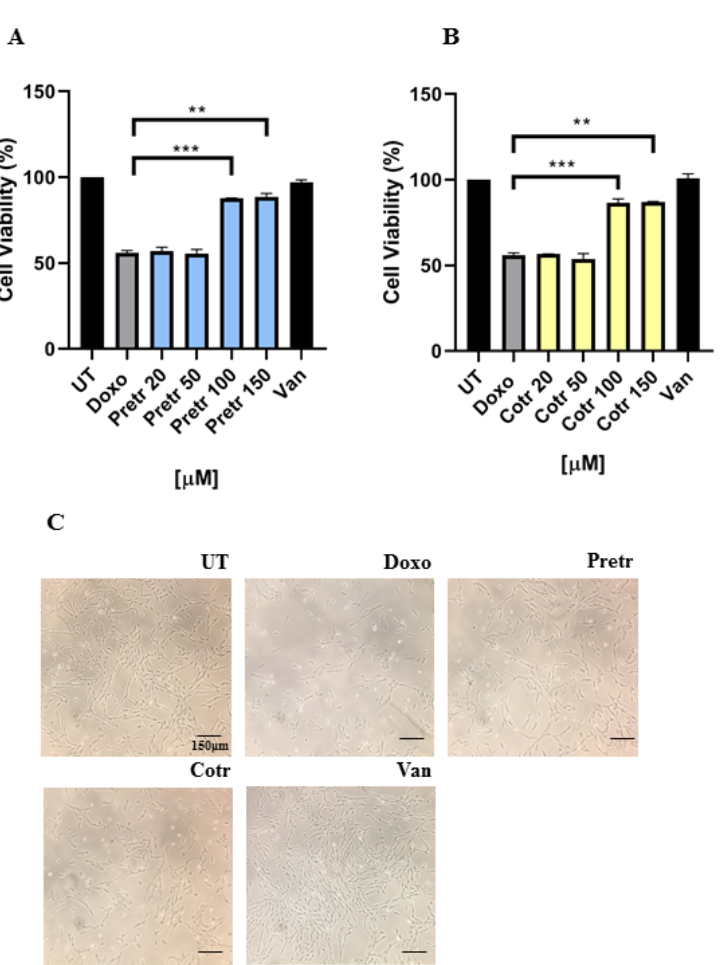
Figure 2. E ff ect of vanillin on doxo-induced cytotoxicity. Cell viability was evaluated by MTT assay in H9c2 cells exposed to doxo for 24 h, ( A ) pretreated and ( B ) co-treated with vanillin at the indicated concentrations. Data are expressed as average percentage of MTT reduction ± SD relative to untreated cells from triplicate wells from 5 separate experiments. UT—untreated cells; doxo—cells exposed to 20- µ M doxo; Pretr—vanillin pretreated cells for 18 h; Cotr—vanillin cotreated cells; Van: cells exposed to 150- µ M Van ( C ) Phase contrast microscopy images taken at the end of treatment time with a higher vanillin concentration. **: p < 0.01; ***: p < 0.001 by one-way ANOVA. Other experimental details are described in Materials and Methods section.